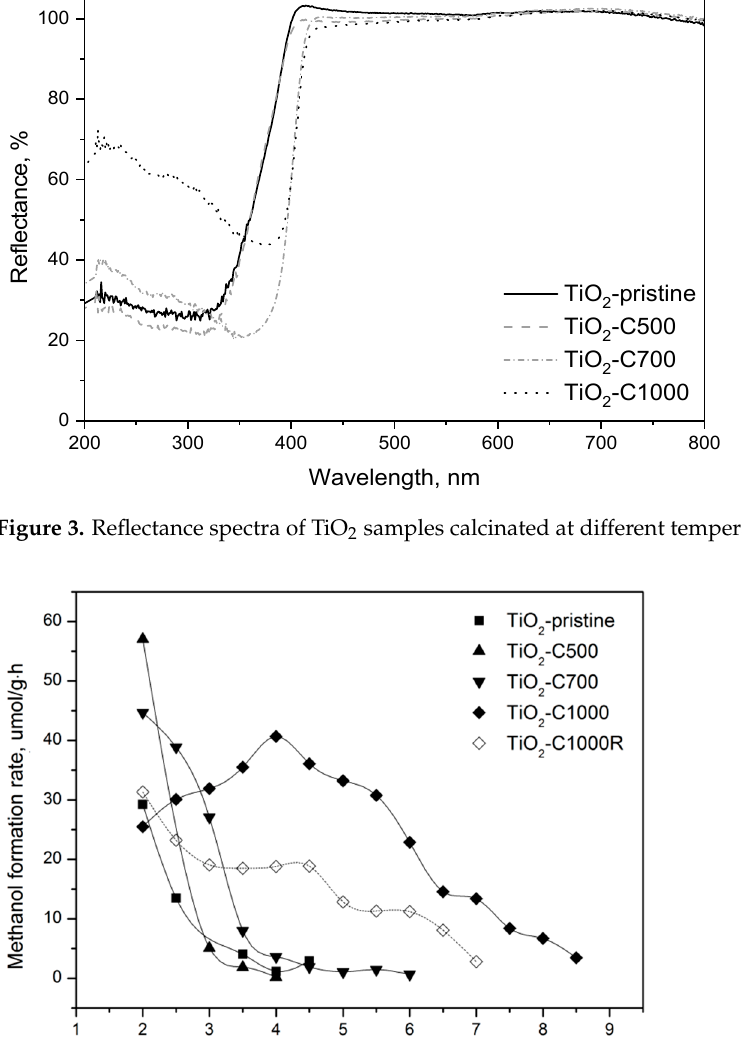
Figure 5. Adsorption of CO 2 ( A ) and desorption of methanol ( B ) on/from the surface of TiO 2 samples. The FTIR studies on the adsorption of CO 2 on the surface of titania revealed also that TiO 2 -C1000 was characterized by not only a lower amount of CO 2 adsorbed but also by a slower adsorption rate than that of the pristine sample. As can be seen from Figure 5A, the adsorption of CO 2 proceeds readily, as evidenced by the notable increase in intensities of characteristic peaks for carbonate species (1358–1695 cm − 1 ) immediately after the